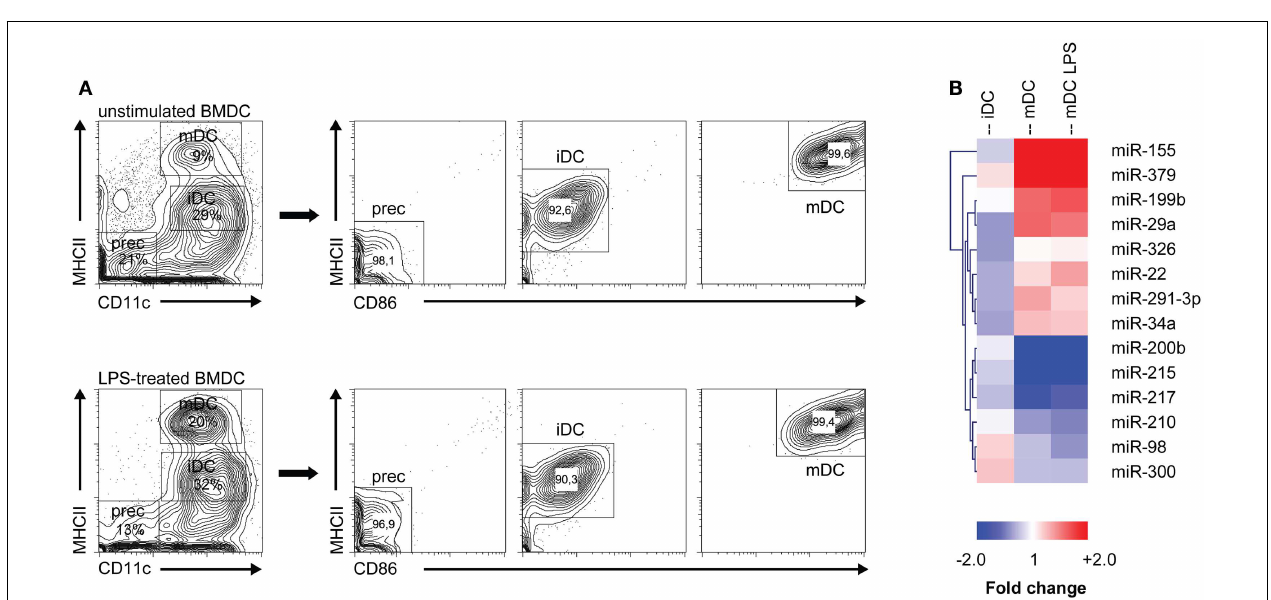
microRNAs (criteria: false discovery rate ≤ 10%; fold change ≥ 1.5 or ≤− 1.5). Each column represents all microRNAs differentially expressed between the DC populations depicted in the heading (iDC, mDC, mDC LPS) and the precursor population. MicroRNA cluster analysis was performed using hierarchical clustering and Euclidean distance